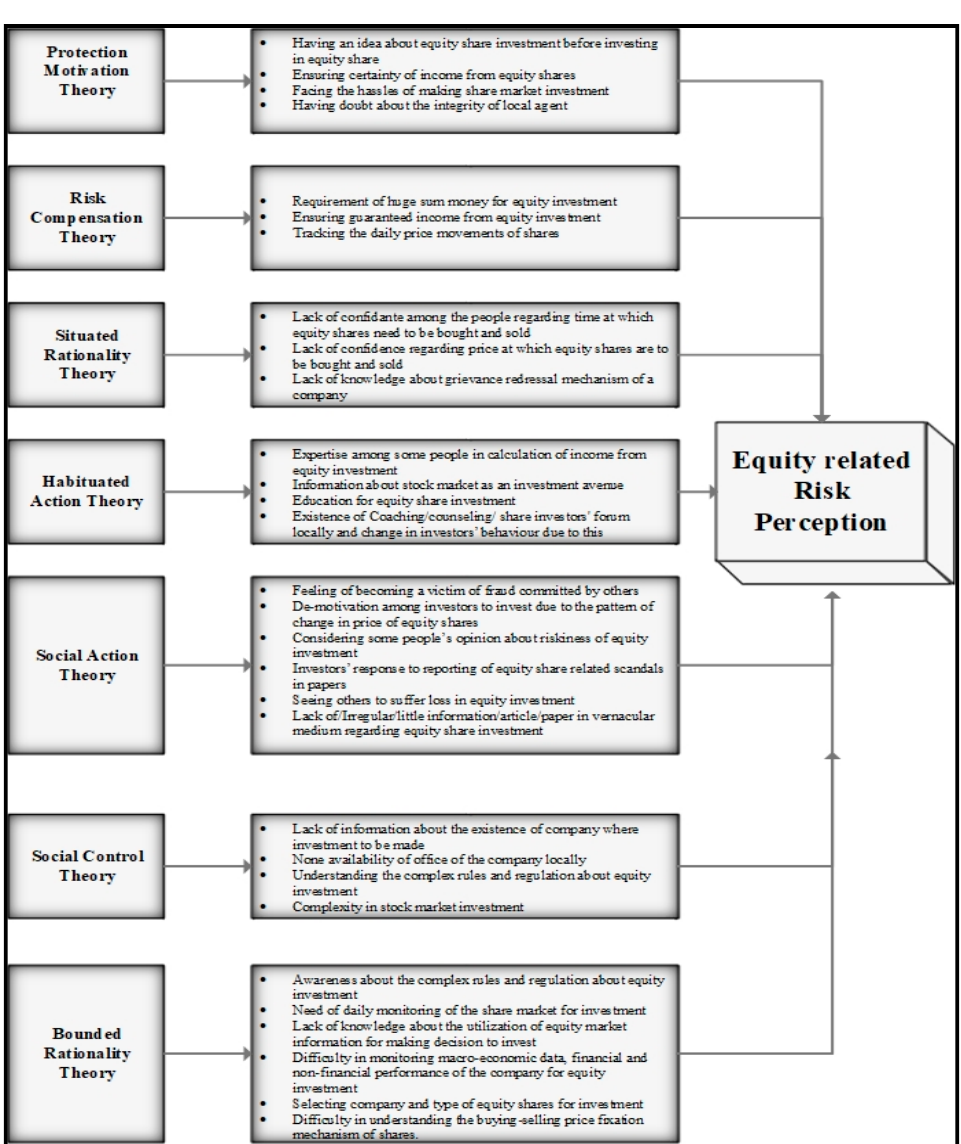
Figure 1. Research framework. Source: Compiled by authors from various sources.